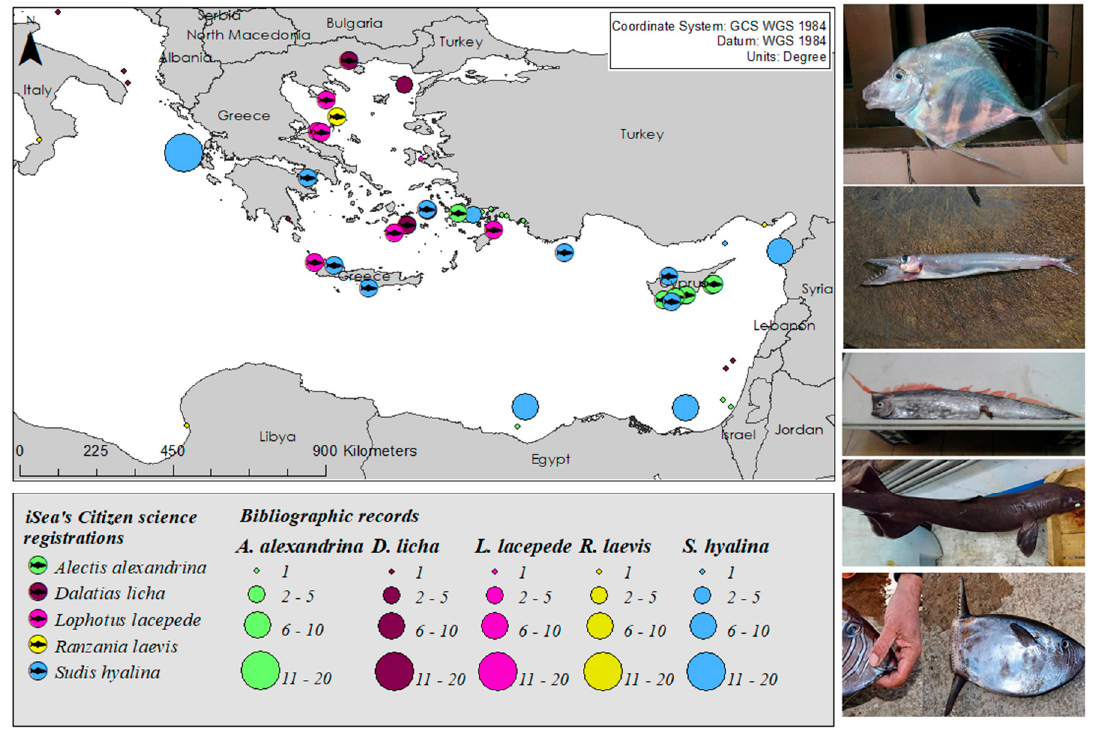
Figure 4. Geographic density dependent bubble plot on five uncommon data-limited species ( Alectis alexandrina, Dalatias licha, Lophotus lacepede, Ranzania laevis and Sudis hyalina ) in the eastern Mediterranean Sea.